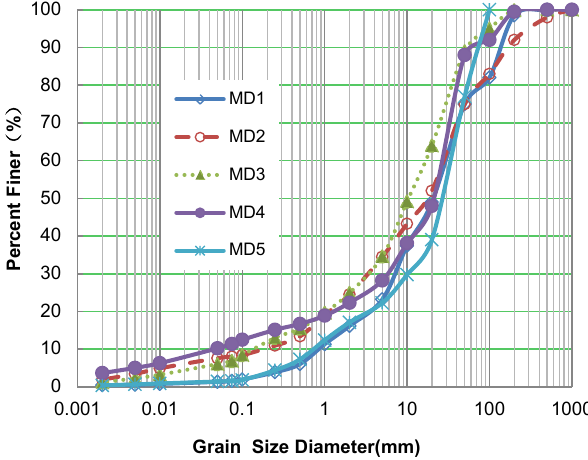
Figure 7. The grain size distribution of soil samples of Midui Valley Fig.7. The particle-size distribution of soil samples of Midui Valley (The horizontal axis is in (the horizontal axis is in log